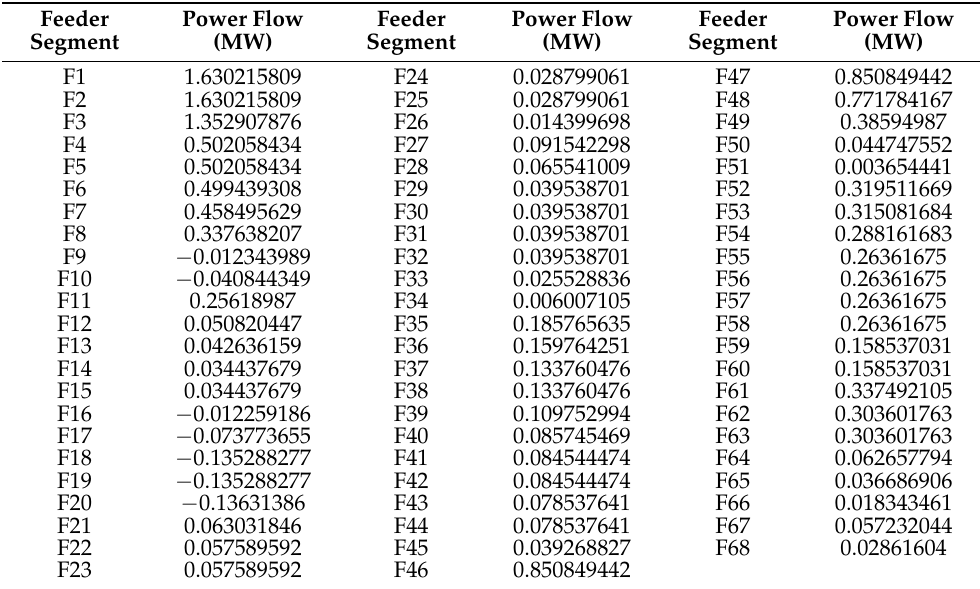
Table 6. Power flow of 69-bus RDS per the average values of loads and DG